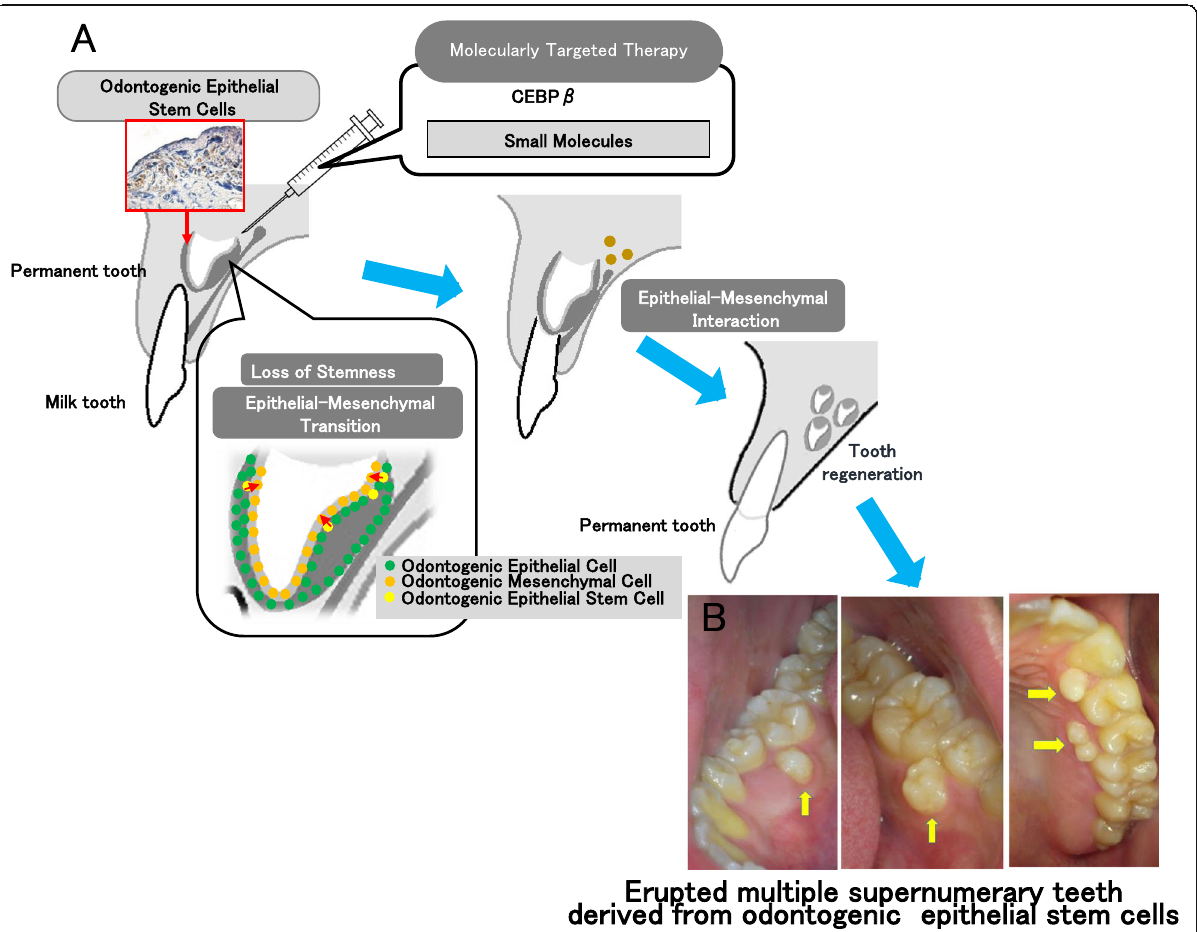
Fig. 4 Development of tooth regenerative medicine targeting odontogenic epithelial stem cells. a Cebpb is involved in maintaining the stemness of enamel epithelial stem cells and suppressing epithelial-mesenchymal transition (EMT). Odontogenic epithelial stem cells (OESCs) are differentiated from one of the tissue stem cells; enamel epithelial stem cells and odontogenic mesenchymal cells are formed from odontogenic epithelial cells by EMT. It was demonstrated that both odontogenic epithelial cells and odontogenic mesenchymal cells, required to form teeth from enamel epithelial stem cells, were directly induced to form excess teeth. b Occlusal view of erupted multiple supernumerary teeth derived from odontogenic epithelial stem cells. The yellow arrows indicate the erupted multiple supernumerary